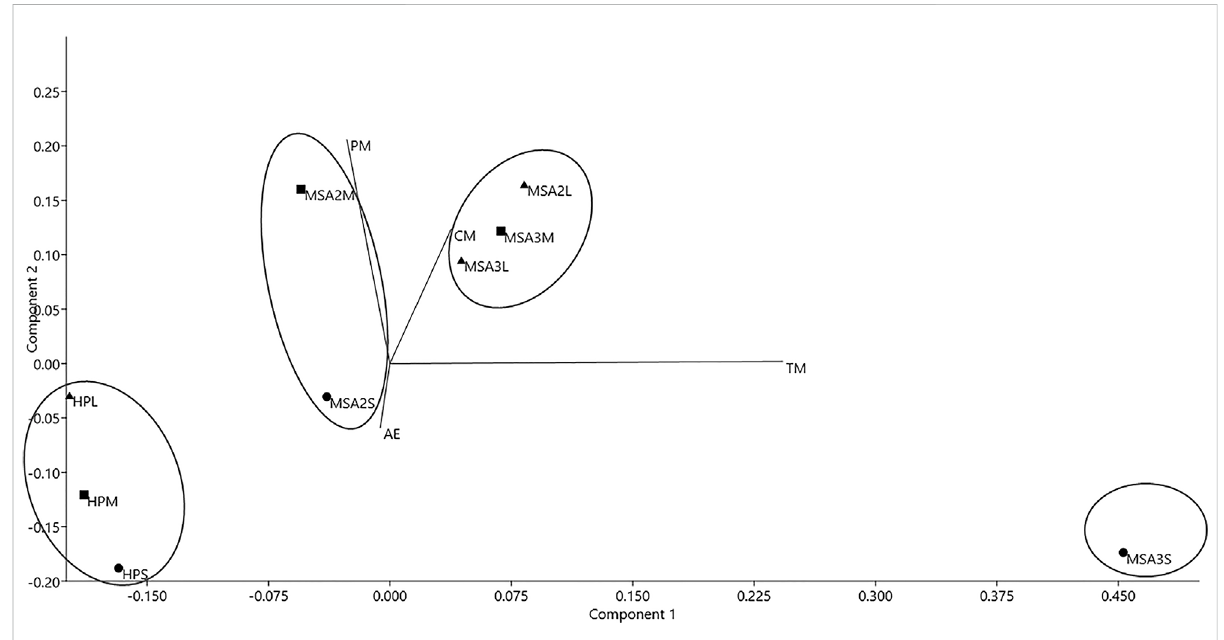
FIGURE 7 Principal component analysis of anthropogenic and zoogenic bone surface modi fi cation for small (s), medium (m) and large (l) mammal size class at Klasies River. Triangles are large mammals, squares are medium-sized mammals, and circles are small mammals. PM = percussion marks. CM = cut marks. TM = tooth marks. AE = acid